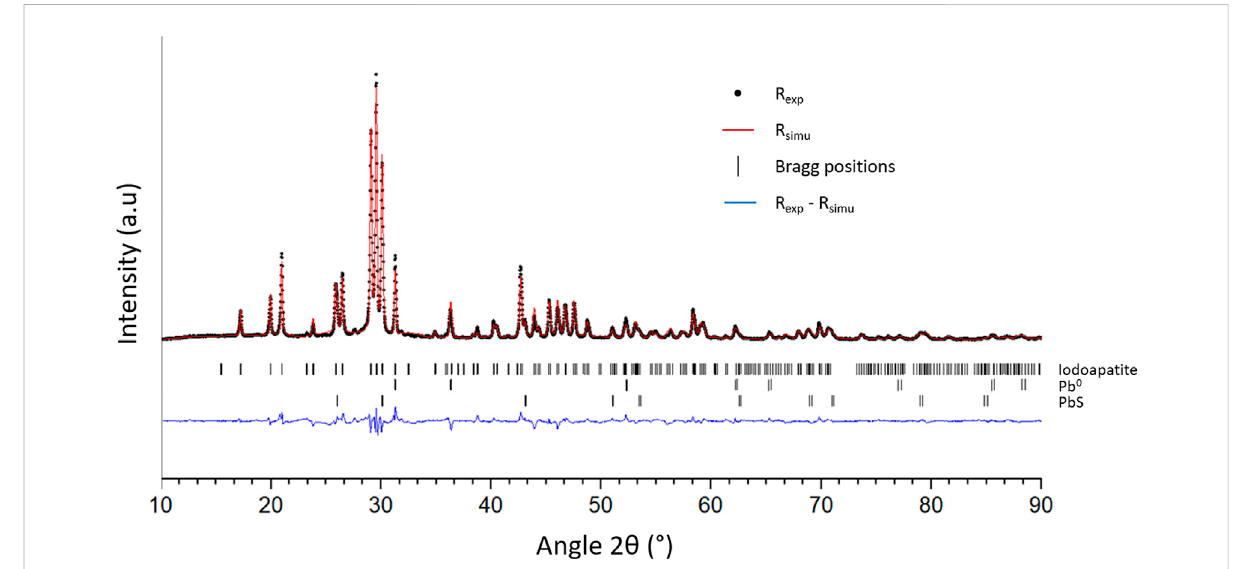
FIGURE 9 Experimental (R exp ) and simulated (R simu ) X-Ray diffractograms of the matrix. Bragg positions of the several phases and intensity differences between R exp and R simu are also